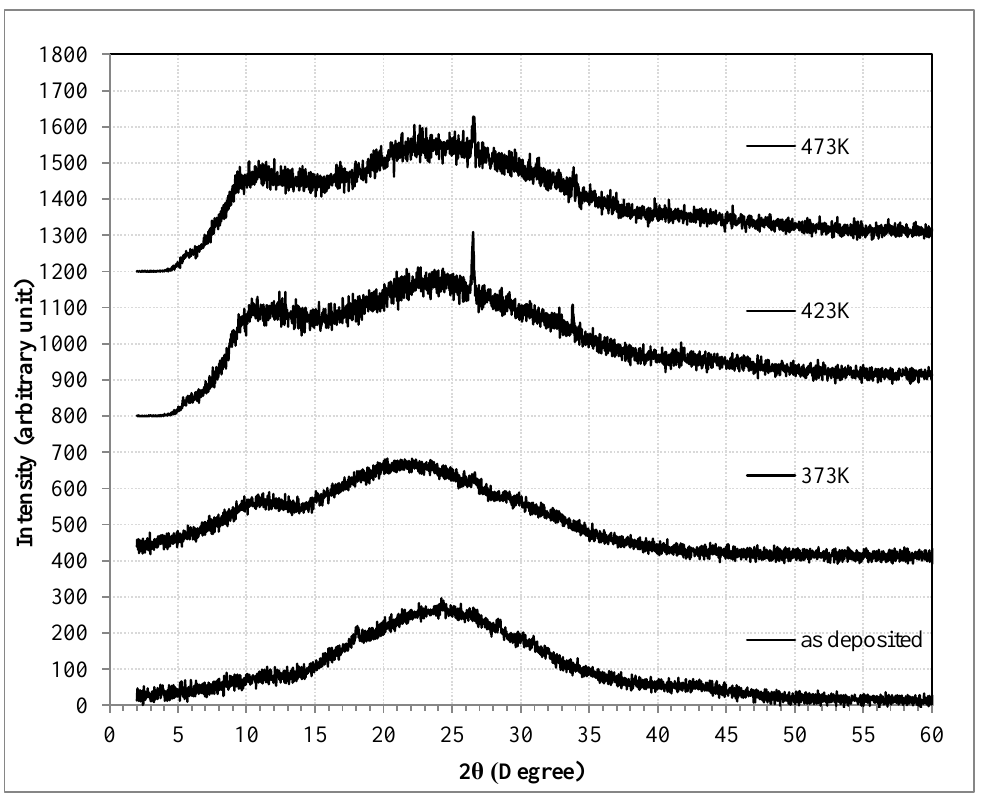
Fig.3: XRD pattern of as-deposited and annealed blend NiPcTs/Alq